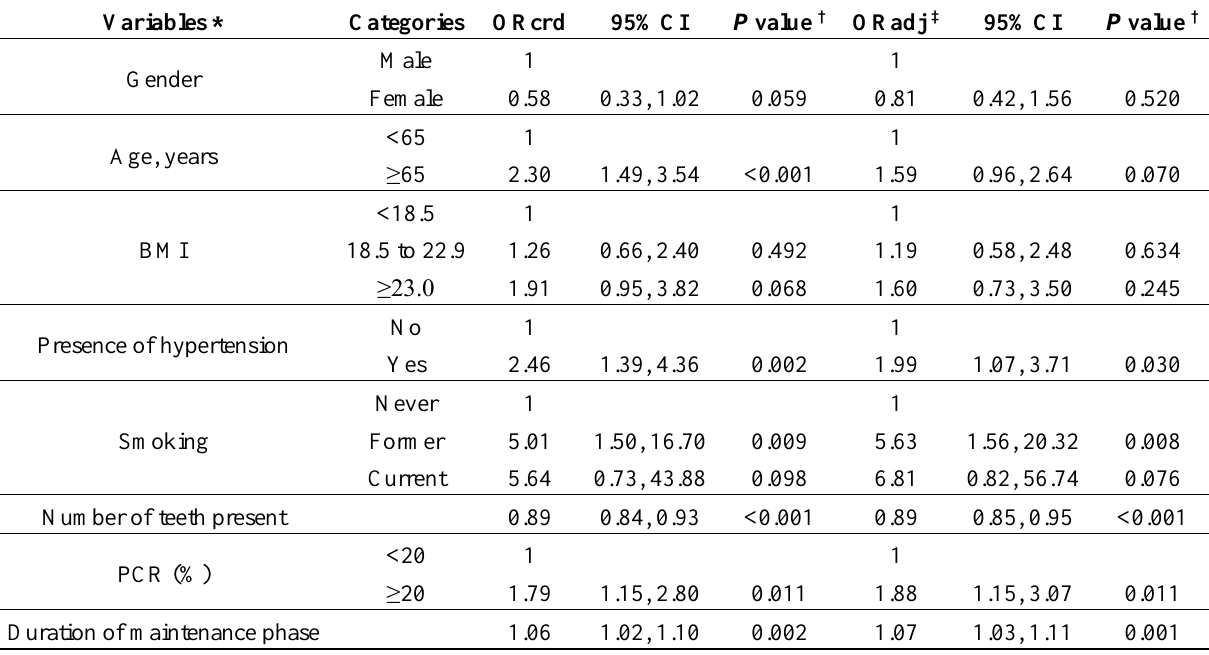
Table 3. Logistic regression analysis with moderate/severe periodontitis as dependent variable. Variables *